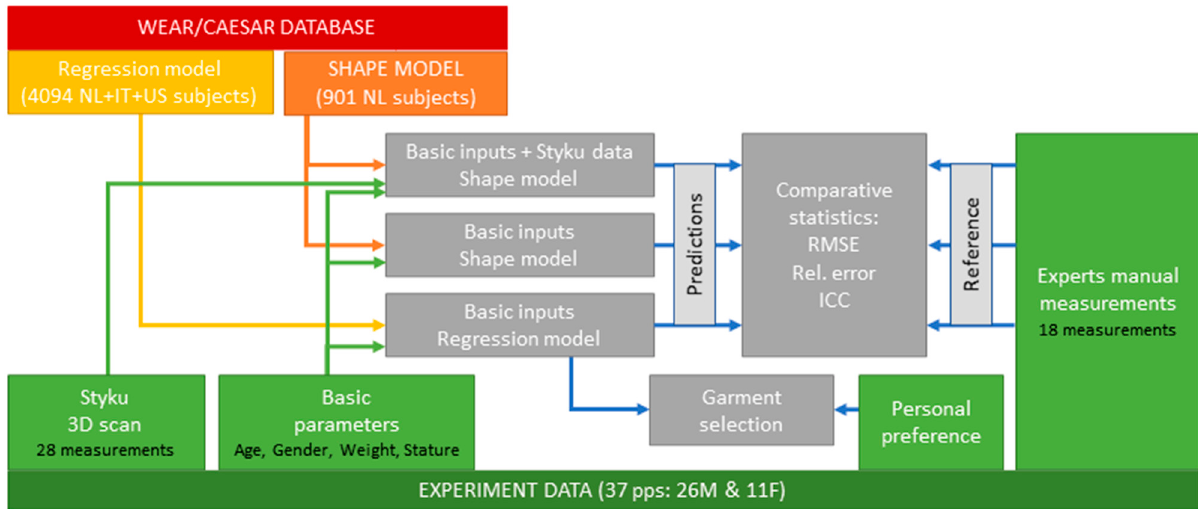
Figure 3. Schematic of the dataflow within the research.